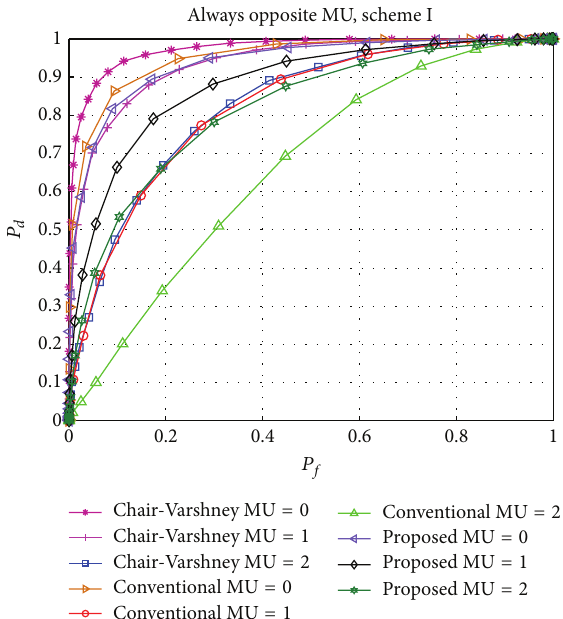
Figure 3: Performance comparison of the Chair-Varshney, conven- tional CSS, and proposed scheme I with always opposite (AO) MUs.